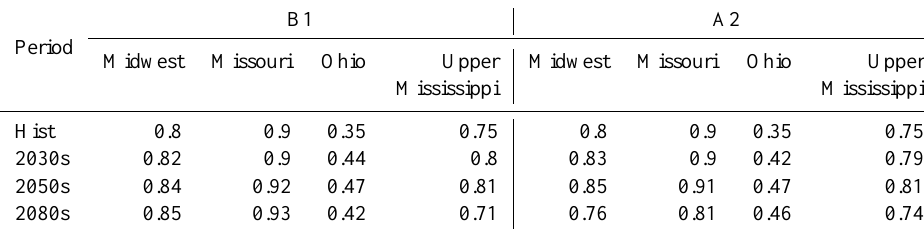
Table 5. Fraction of total demand attributed to the irrigation sector. B1 A2 Period Midwest Missouri Ohio Upper Midwest